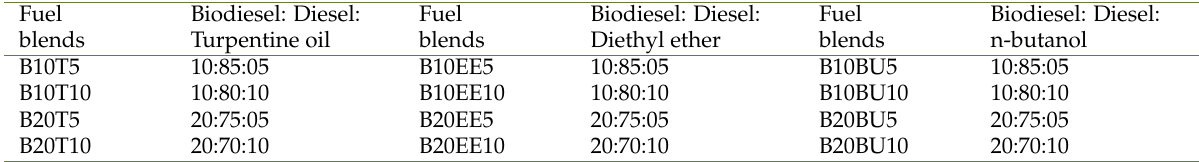
Table 2. Fuel composition blending ratios of Neem biodiesel with turpentine oil, diethyl ether, and n-butanol (by volume %).